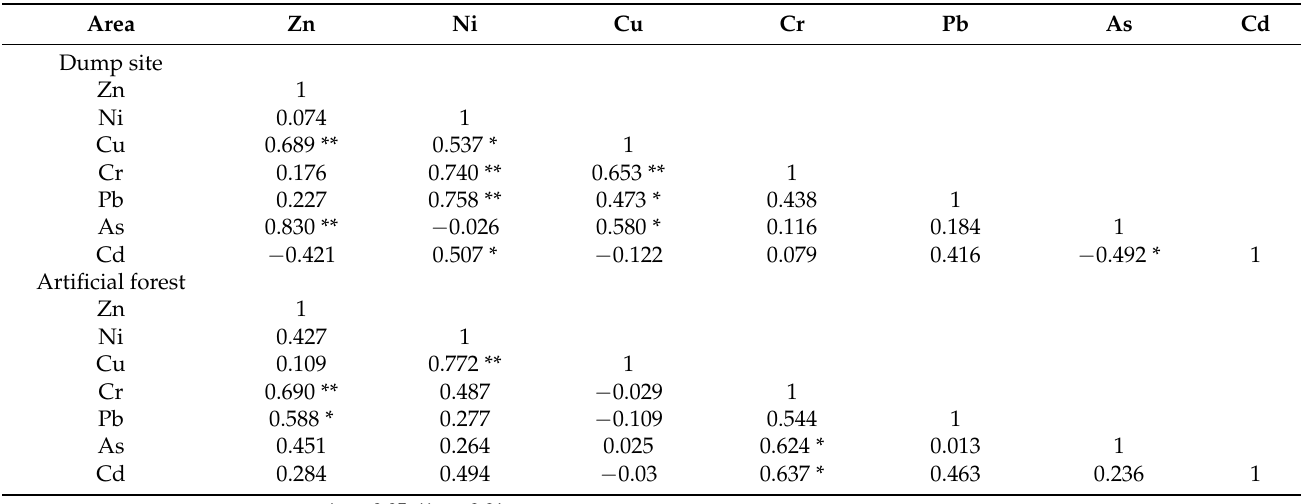
Table 5. Correlation Analysis.